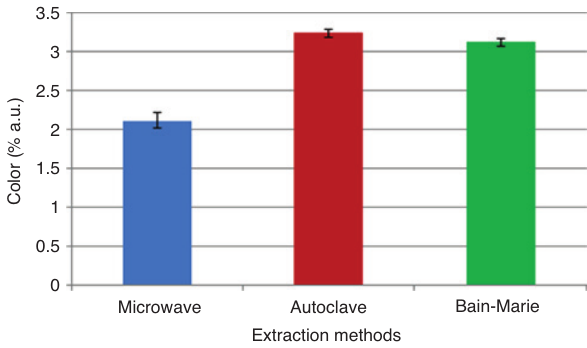
Figure 5: Color intensity of the saponin extracts obtained using three different extraction methods. Data are mean values of three